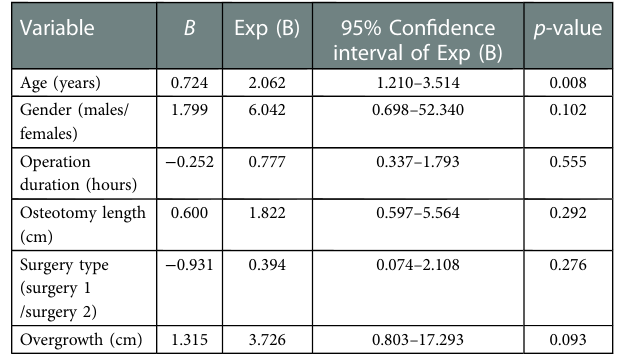
TABLE 5 Risk factor analysis of children with LLD ≥ 1 cm after DDH operation.